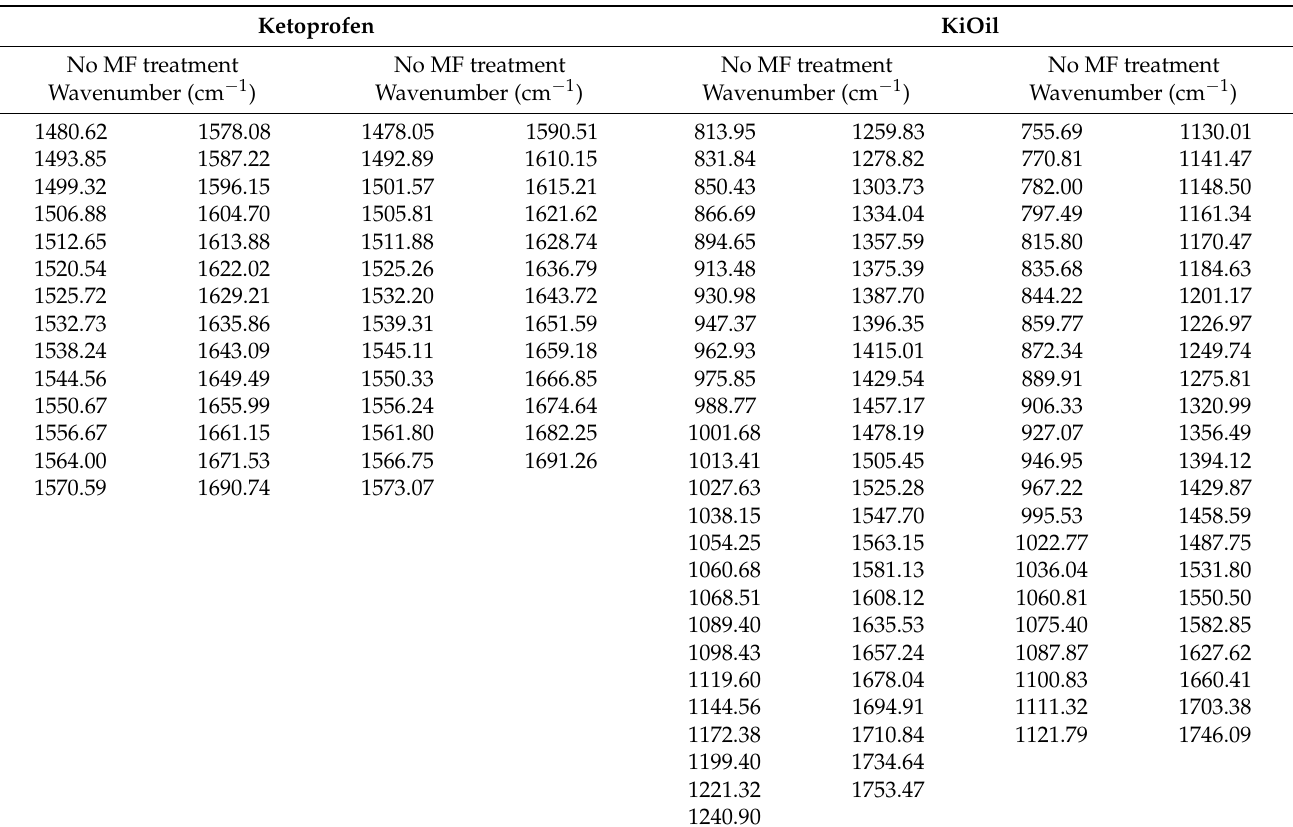
Table 2. Wavenumber obtained from curve fitting analysis of the FTIR spectrum. Ketoprofen